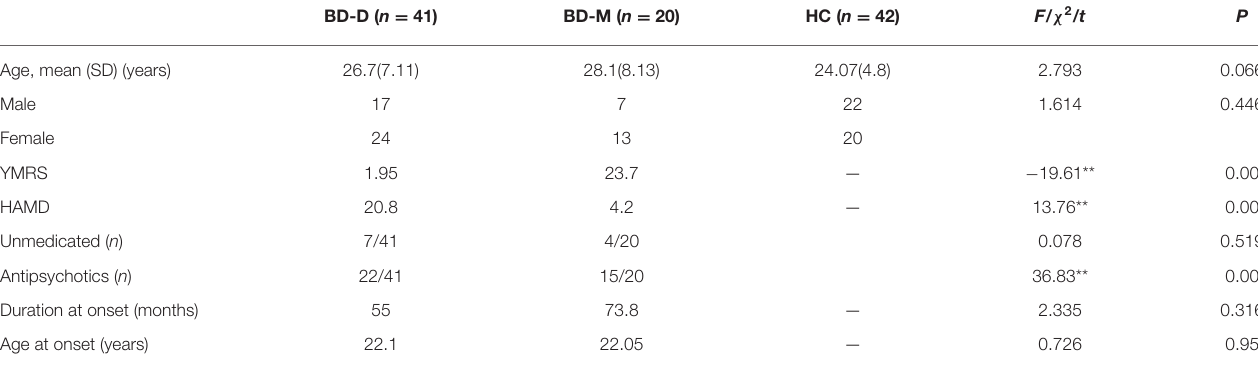
TABLE 1 | Subjects demographic and clinical characteristics.